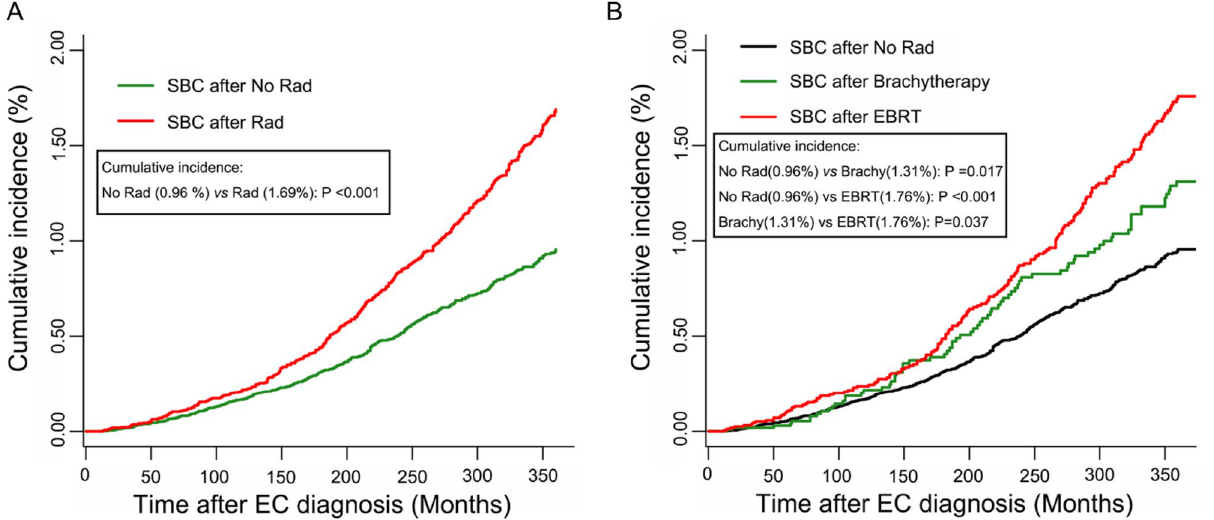
Figure 2. The cumulative incidence of secondary bladder cancer (SBC) in EC survivors. ( A ) Comparison of cumulative incidence between patients received radiotherapy or not; ( B ) Comparison of cumulative incidence among patients received different RT modality. P values were calculated with the Gray test. Rad, Radiotherapy; SBC, secondary bladder cancer; EC, endometrial cancer; EBRT, external-beam